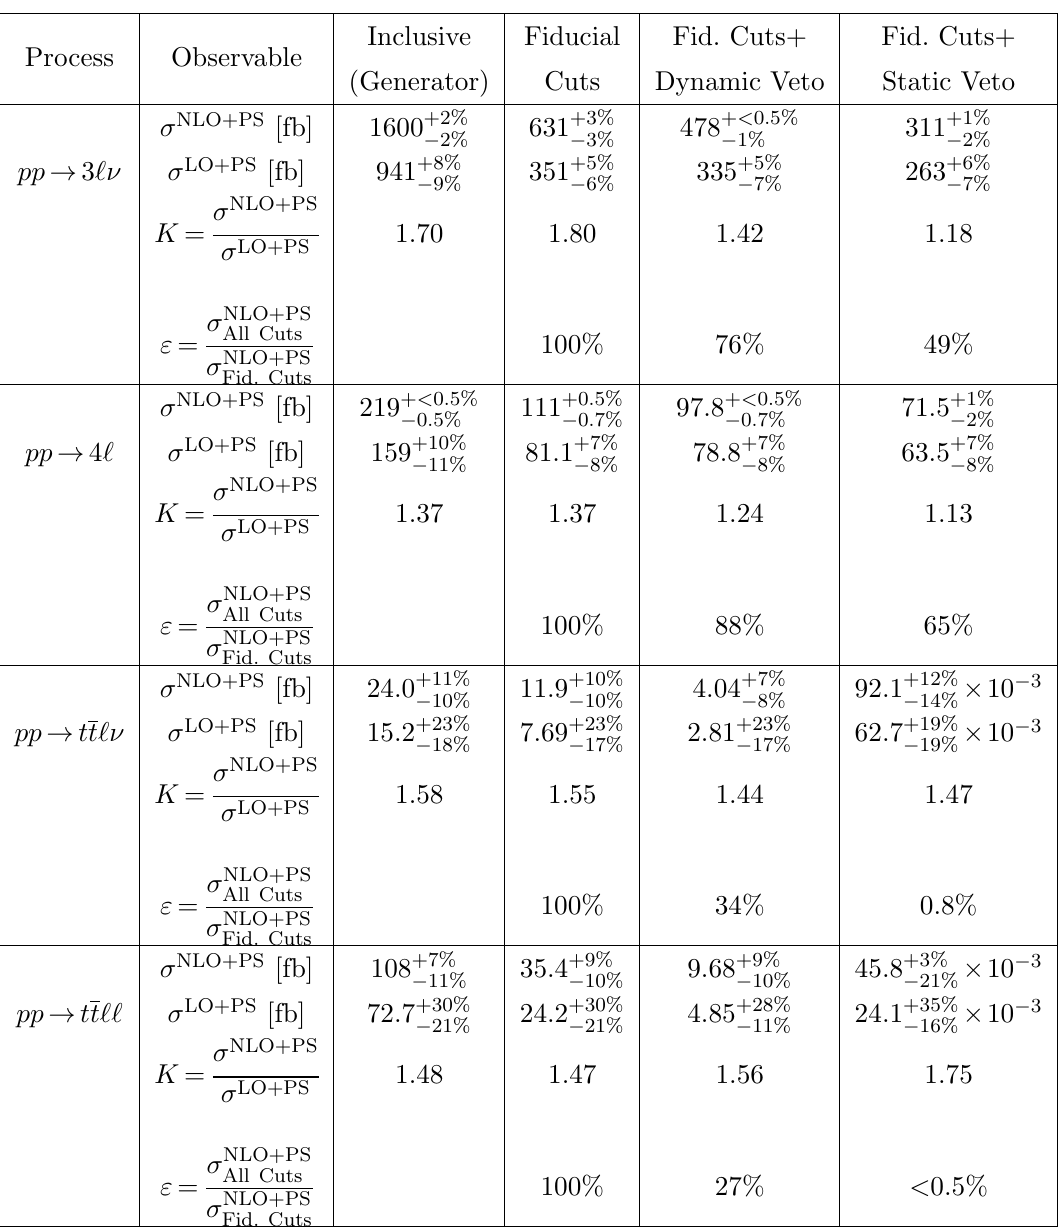
Table 4. Same as table 2 but for representative SM background